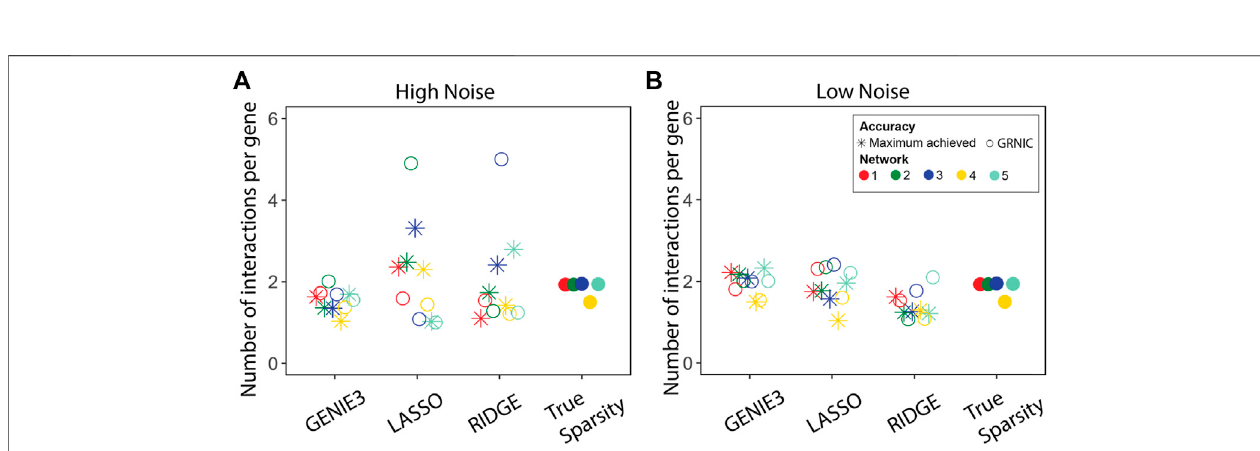
FIGURE 2 | Performance evaluation of the sparsity selection pipeline in terms of the F1-score. F1-scores of the inferred GRNs from datasets generated by GeneNetWeaver with (A) high and (B) low noise levels. Each panel contains F1-scores from fi ve datasets for two categories: GRNIC (circle) and maximum achieved in inference (star).